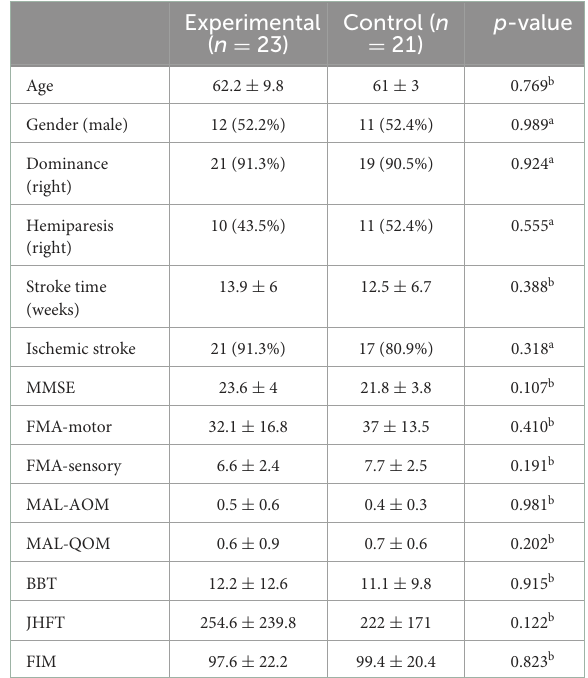
TABLE 1 Demographic and stroke characteristics for each group at